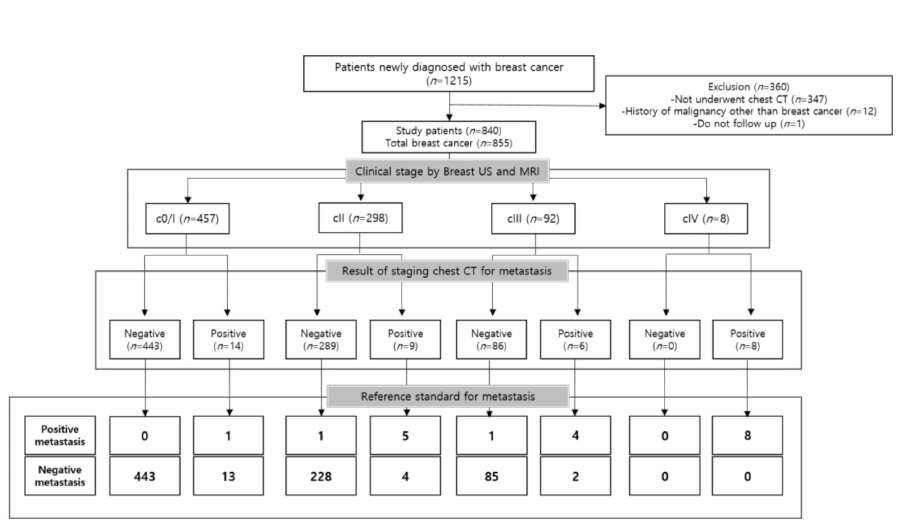
Figure 1. Patient flow diagram showing reference standard for metastasis based on clinical